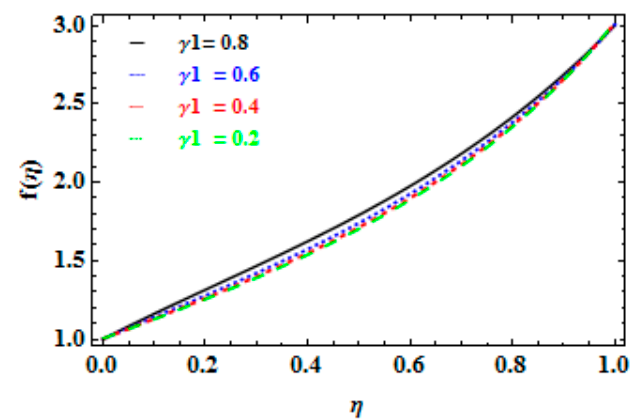
Figure 8. Influence of γ 1 on f (cid:48) ( η )